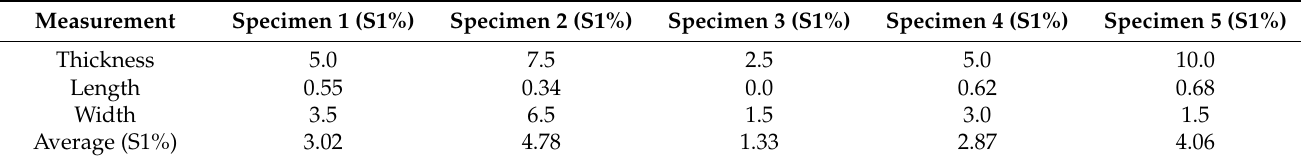
Table 13. Dimensional errors of L-PBF printed parts.